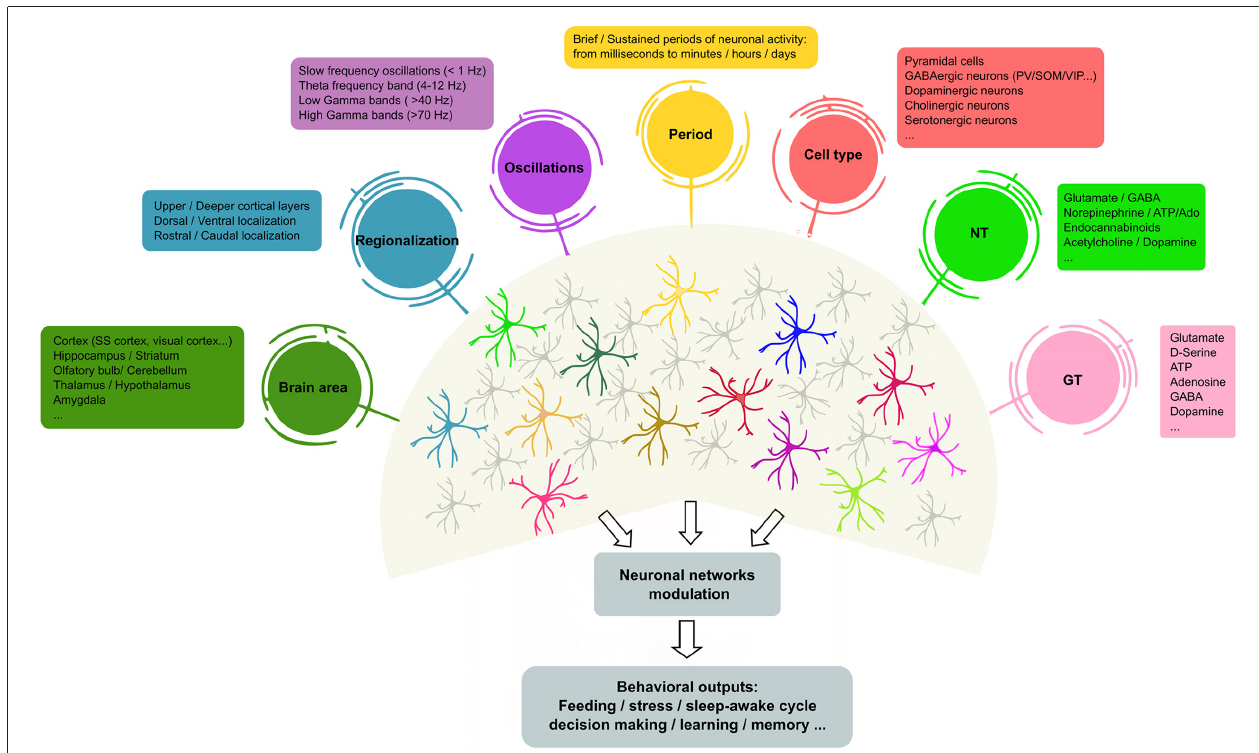
FIGURE 1 | Heterogeneity of astrocyte–neuron networks. Astrocytes are able to respond to different NTs, cell types in different brain areas and under diverse patterns of stimulation. In turn, astrocytes modulate the activity of ion channels and neurotransmitter transporters in their membranes, but also release different active substances (so-called GTs, e.g., glutamate, gamma-aminobutyric acid (GABA), adenosine and D-serine, among others) that contribute to shape neuronal activity. However, it remains unclear whether the same or different astrocyte subtypes mediate these differential effects. The scheme illustrates recent evidence of the molecular and functional diversity of astrocytes that may underlie the outcomes of brain activity. In this context, single astrocytes can be affected by more than one physiological feature (represented as colored circles that connect to astrocytes), or subsets of astrocytes may show preferential links with particular physiological features, suggesting the existence of different astrocyte populations that exhibit specific properties (astrocyte color code). NTs, neurotransmitters; GTs, gliotransmitters; SS, somatosensory; PV, parvalbumin positive cells; SOM, somatostatin positive cells; VIP, vasoactive-intestinal